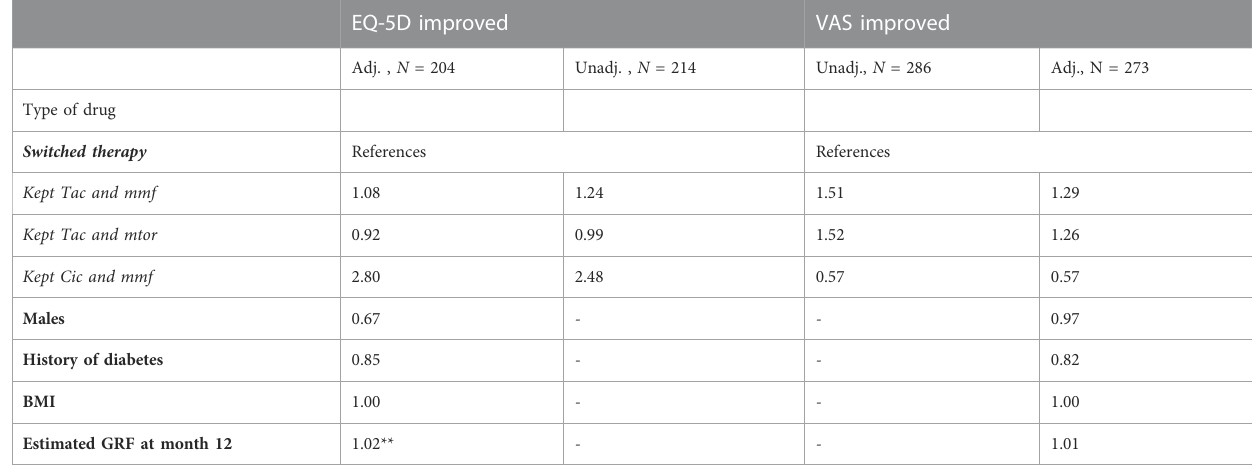
TABLE A2 Improvement in raw scores (EQ-5D or VAS from baseline to visit M12, presented in odds